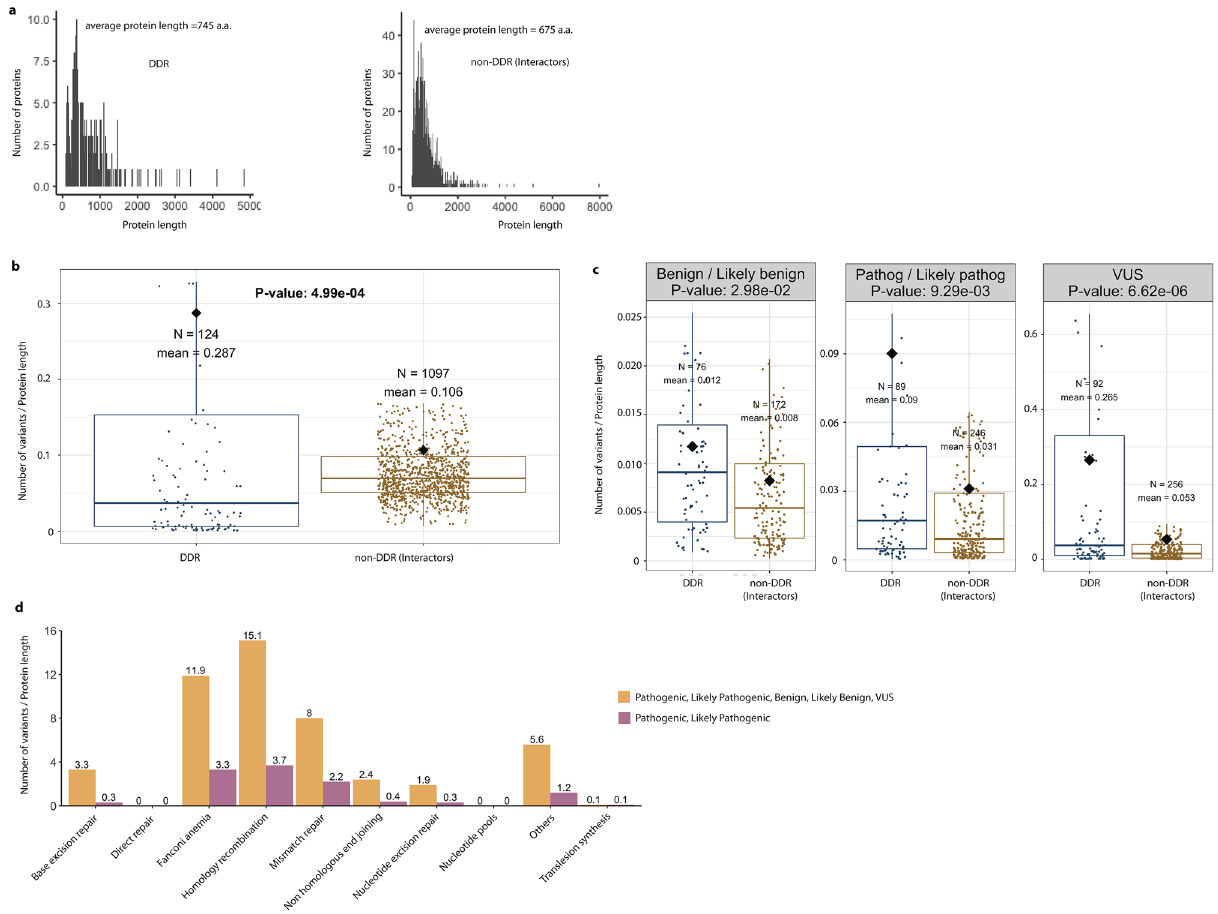
Figure 2. Distributions of germline variants in DDR and non-DDR interactors. Panel ( a ) shows the distribution of protein lengths for DDR and non-DDR proteins. Their average lengths are similar, being 745 a.a and 675 a.a, respectively. Boxplots show the contrasting patterns of germline variants as a function of protein length in the DDR and non-DDR proteins (panel b ), and as categorized into benign, pathogenic, and VUS (panel c ). Outliers in panel b and c were removed here for clarity, but included in the T-test statistical analysis. Some genes occur in two or three of the categories in panel ( c ), hence the sum of the N values shown is higher than the N in the corresponding plot in panel b which is the number of unique DDR genes. All boxplots depict the first and third quartiles as the lower and upper bounds of the box, with a thicker band inside the box showing the median value, and whiskers representing 1.5 × the interquartile range. Panel d shows the accumulation of germline variants in biological pathways related to the 229 DDR